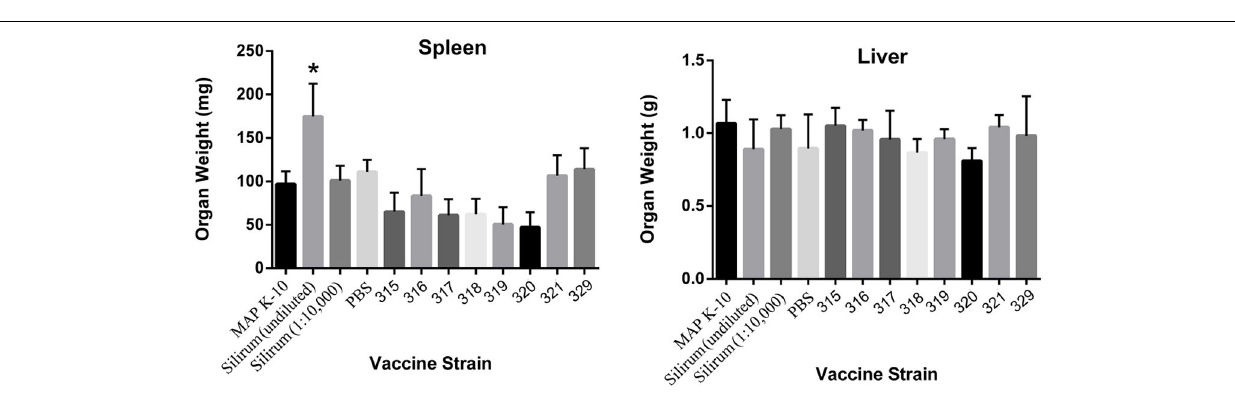
treated mice compared to other treatment groups are indicated by an asterisk ( P < 0 . 05 for 329; P < 0 . 01 for 321 and PBS; P < 0 . 005 for K-10, diluted Silirum and 316; P < 0 . 0005 for 315, 317, 318, 319, and